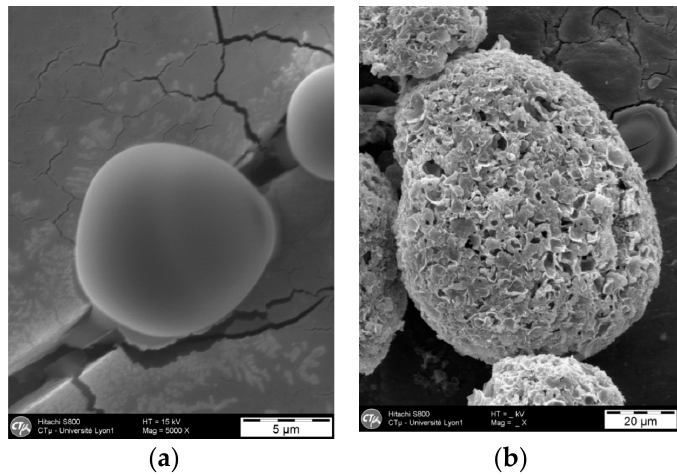
Figure 2. Microparticles before ( a ) and after ( b ) breaking treatment.